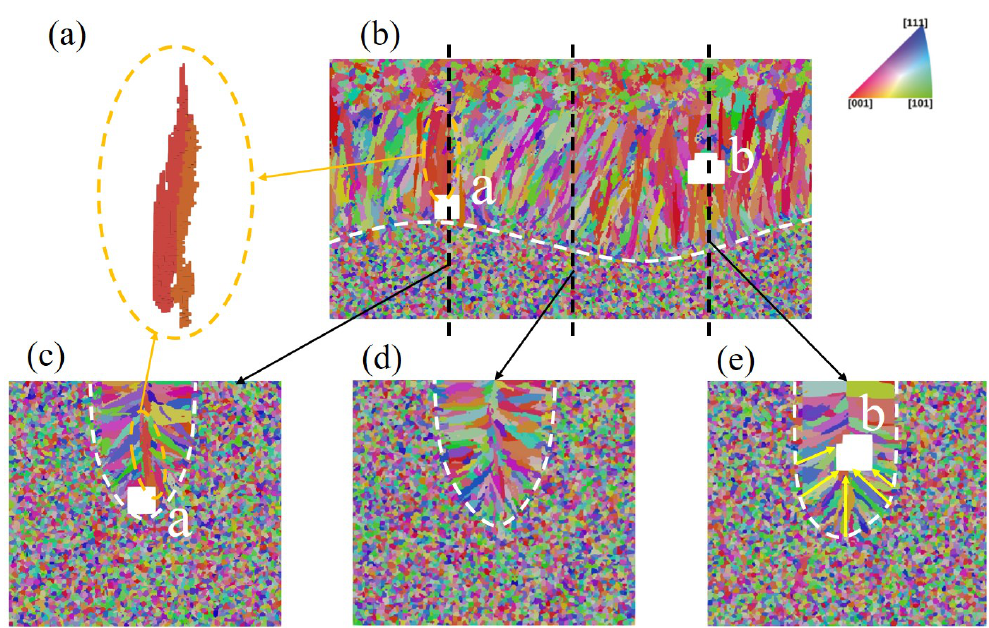
Figure 25. Microstructure near the pores: ( a ) coarse grains above pores a , ( b ) longitudinal cross- section map of the grain structure, where the black dotted lines indicate the location of the transverse cross-section maps for ( c ) with the presence of Pore a ( d ) without the presence of Pore and ( e ) with the presence of Pore b , where white dotted lines represent the boundary of the melting zone and yellow arrow marks several grains blocked by Pore b .